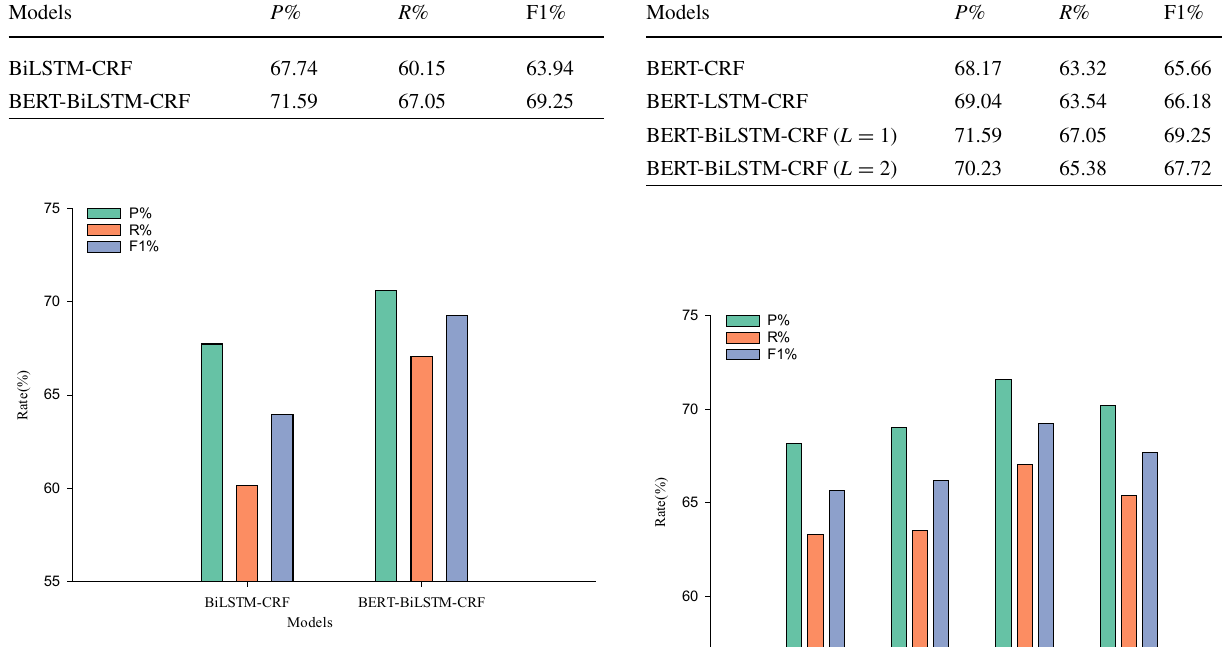
Fig. 4 Comparison of experimental results of different models